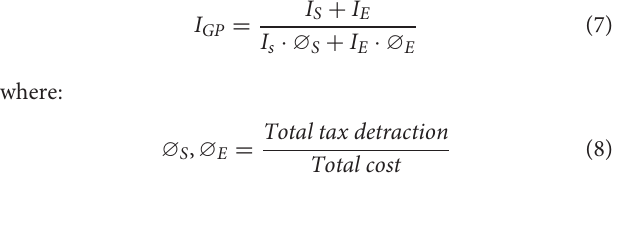
TABLE 11 | Risk classes attributed from vulnerability classes.